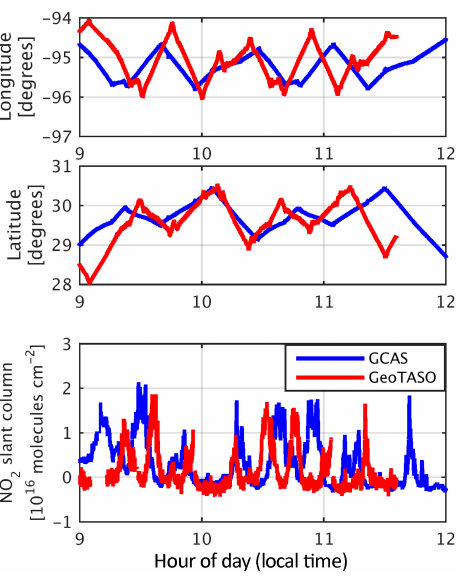
Figure 16. GCAS and GeoTASO (a) longitude; (b) latitude; and (c) retrieved NO 2 slant column as a function of time during the two morning 13 September 2013 Houston overpasses.